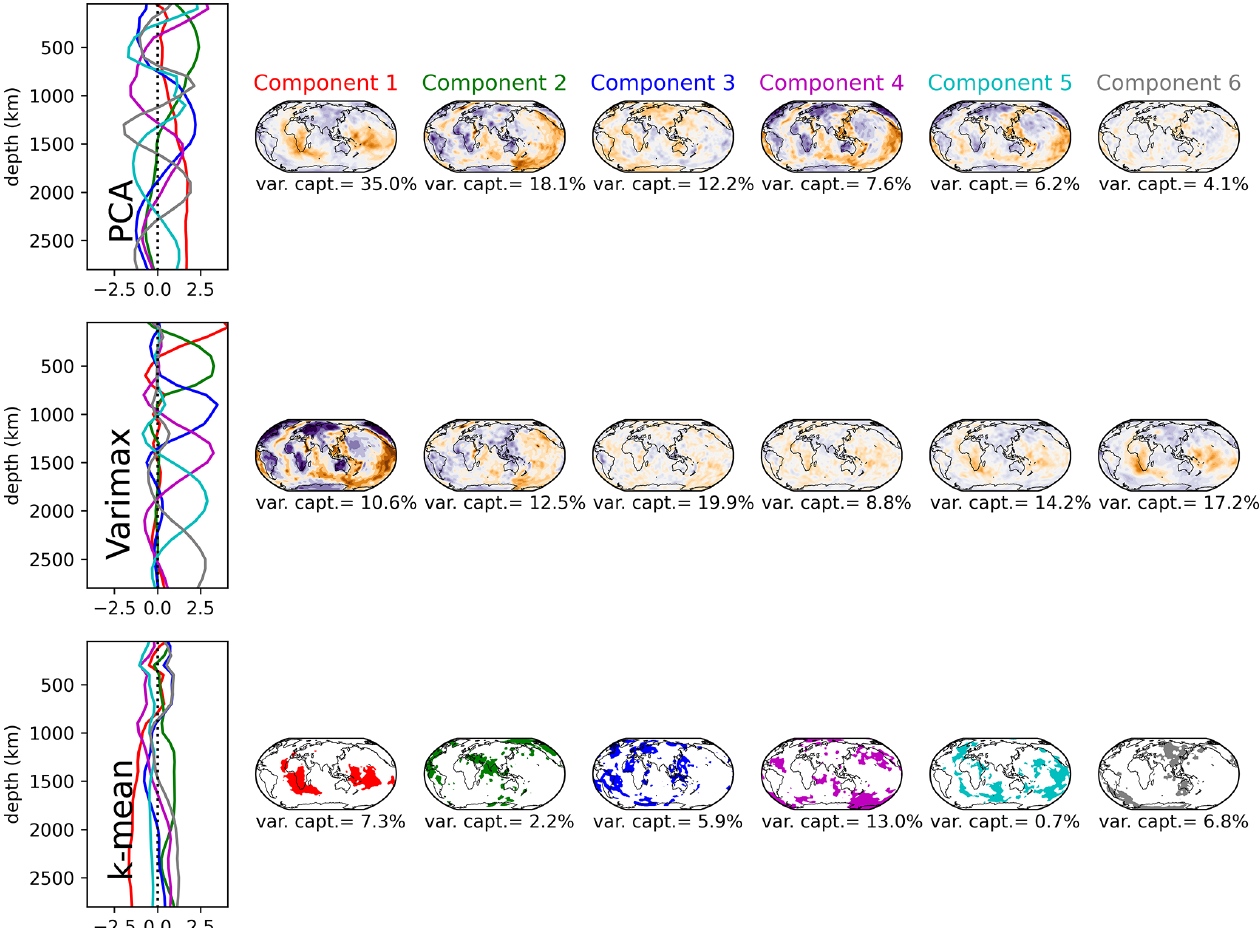
Figure 1. Results from the PC, varimax and k -means methods applied to the model S40RTS using six principal components. The varimax PC and loads are normalised in such a way that the horizontal patterns (load) range between − 1 and 1, with orange corresponding to negative, blue to positive and white to zero, with the intensity being proportional to the value. We note that while this normalisation eases the analysis, it does not lead to a loss of information (see main text for details). Unlike the classical variance-based sorting of the principal components, we order the varimax components by the depth of the profile’s maximum.